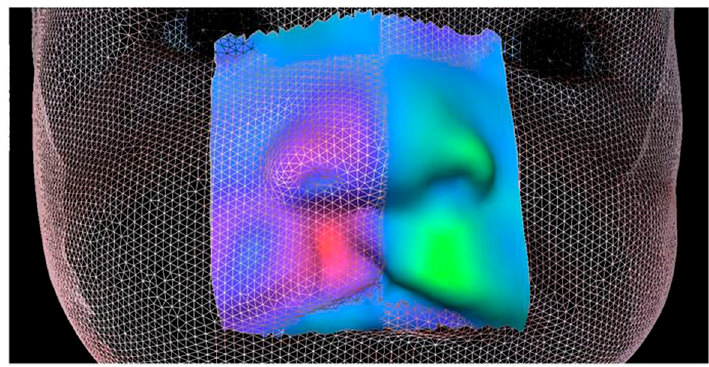
Figure 3. Overlap 3D of the pre- and post-treatment faces.